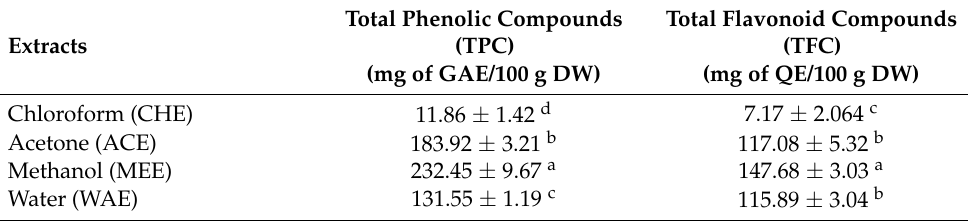
Total Flavonoid Compounds Total Phenolic Compounds (TPC) (mg of GAE/100 g DW)